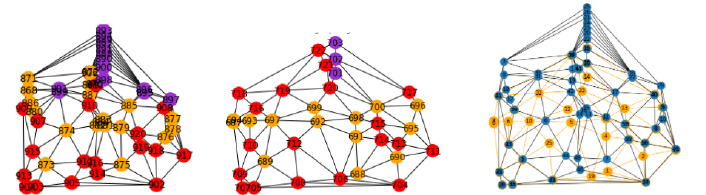
Figure 7. Resulting graphs for graph #17. ( Left ): OSM 2020, ( Middle ): IGN 2019. Node labels are color coded: red = buildings, orange: roads, violet: rail. ( Right ): superimposed IGN (orange) and OSM (blue)